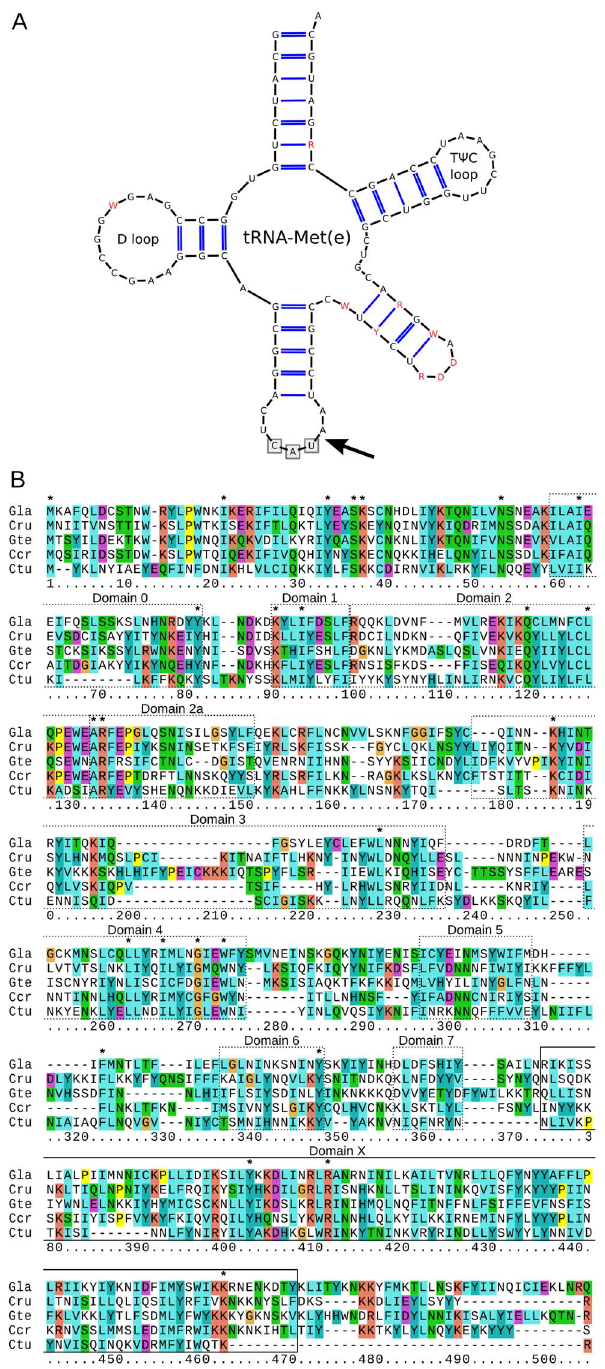
Figure 3. Conserved group II intron in florideophyte plastid trnMe . (A) Model of hypothetical secondary structure of the newly identified elongator methionine tRNA showing the position of the intron inserted after the third anticodon position (arrow). Residues in red differ among florideophytes. (B) Sequence alignment of the intron- encoded reverse transcriptase/maturase from five florideophyte plastid genomes with putative reverse transcriptase domains shown by dotted line boxes, the maturase domain shown by a solid line box, and conserved residues shown by asterisks (Gla Grateloupia lanceola ; Cru Cruoria sp.; Gte Gracilaria tenustipitata ; Ccr Chondrus crispus ; Ctu Calliarthron tuberculosum ).